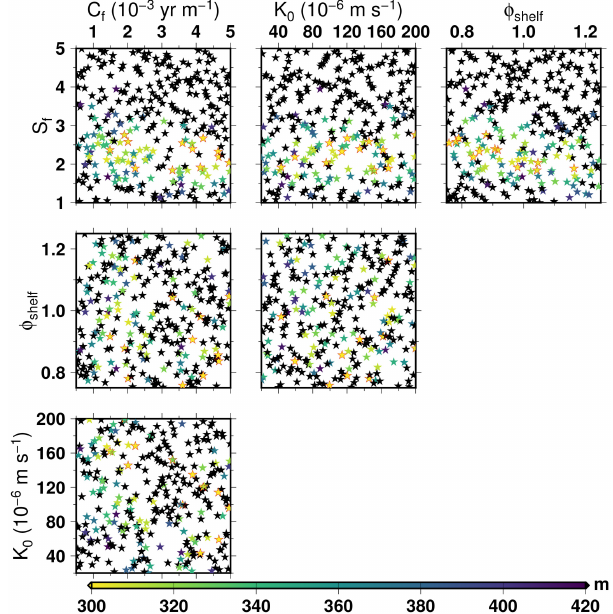
Figure 9. Ice thickness root mean square error respective to ob- servations in the parameter space for the 300 model members us- ing the Schoof (2007) formulation of the flux at the grounding line (AN40S). The 12 experiments showing the lowest error are outlined in red.